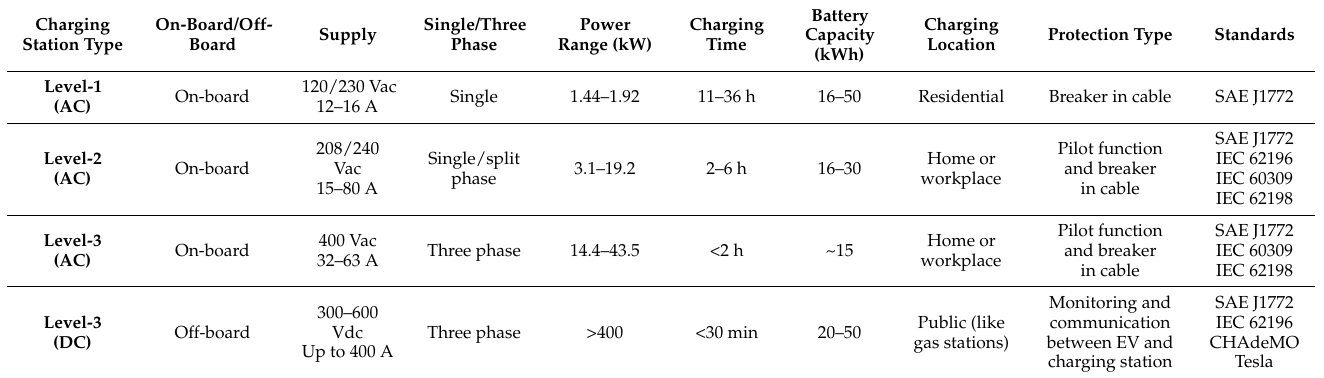
Table 2. EVs charging levels, specifications, and